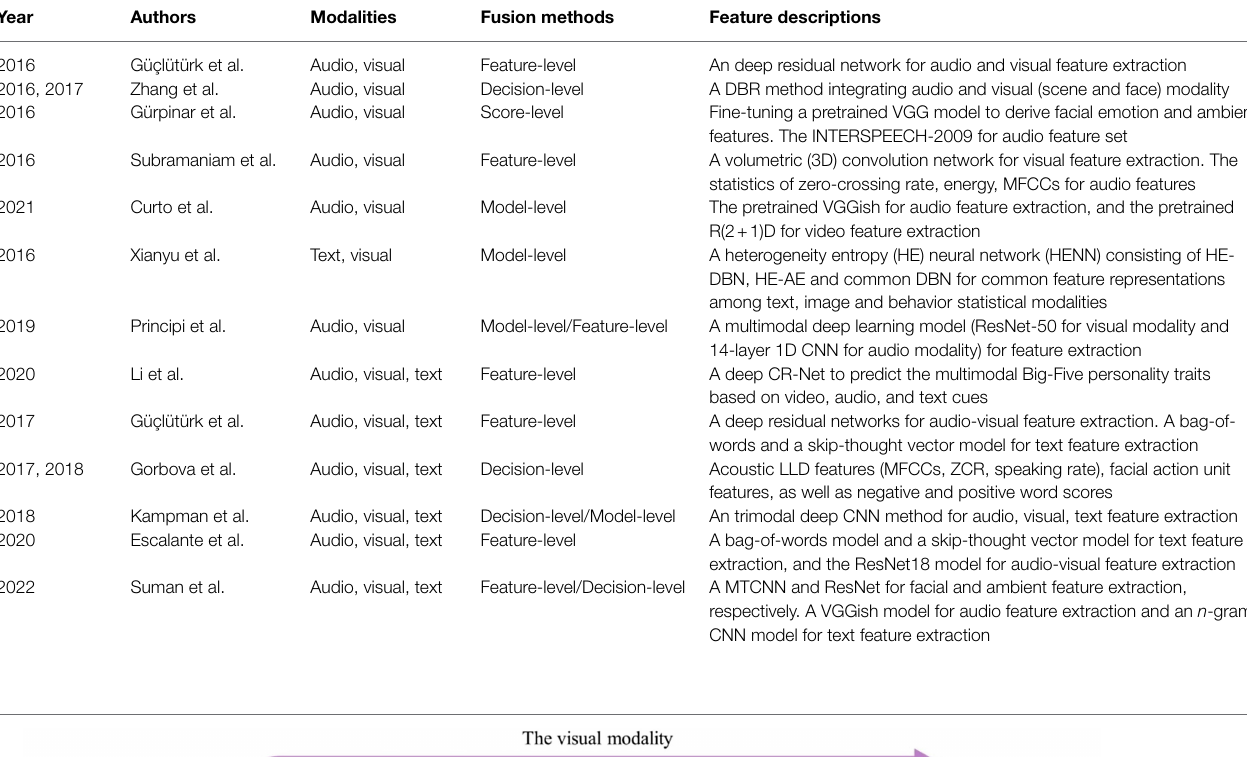
TABLE 6 | A brief summary of multimodal fusion for personality trait recognition.